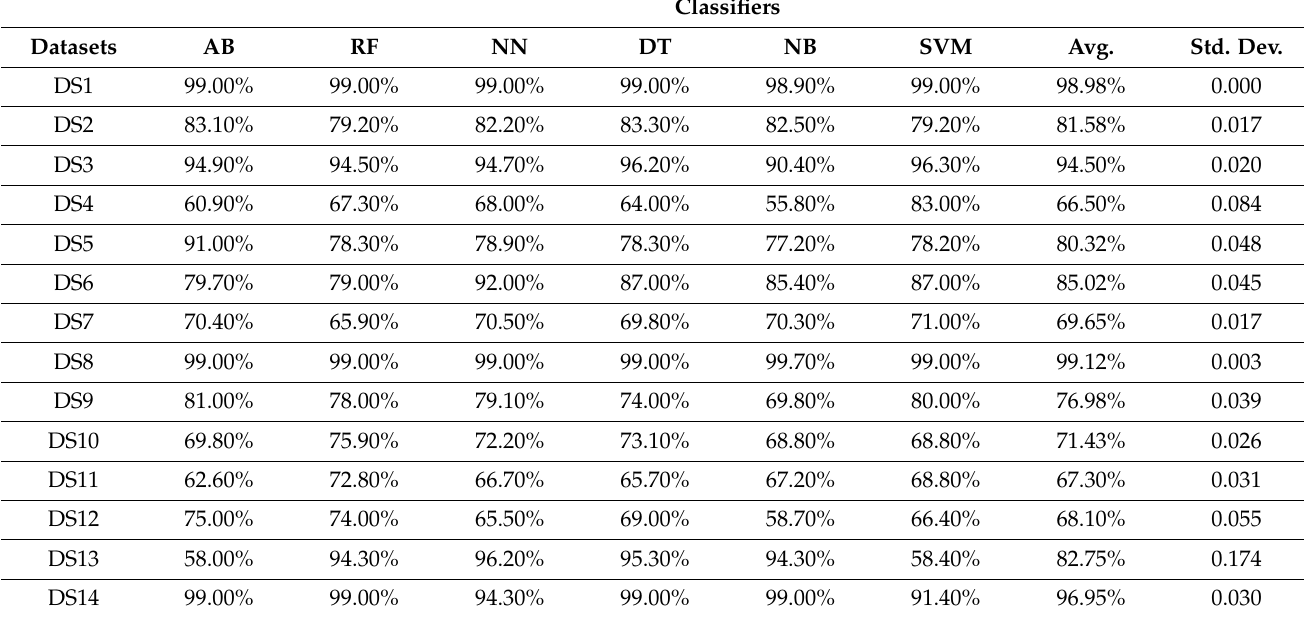
Table A3. F-score of classifiers trained on small